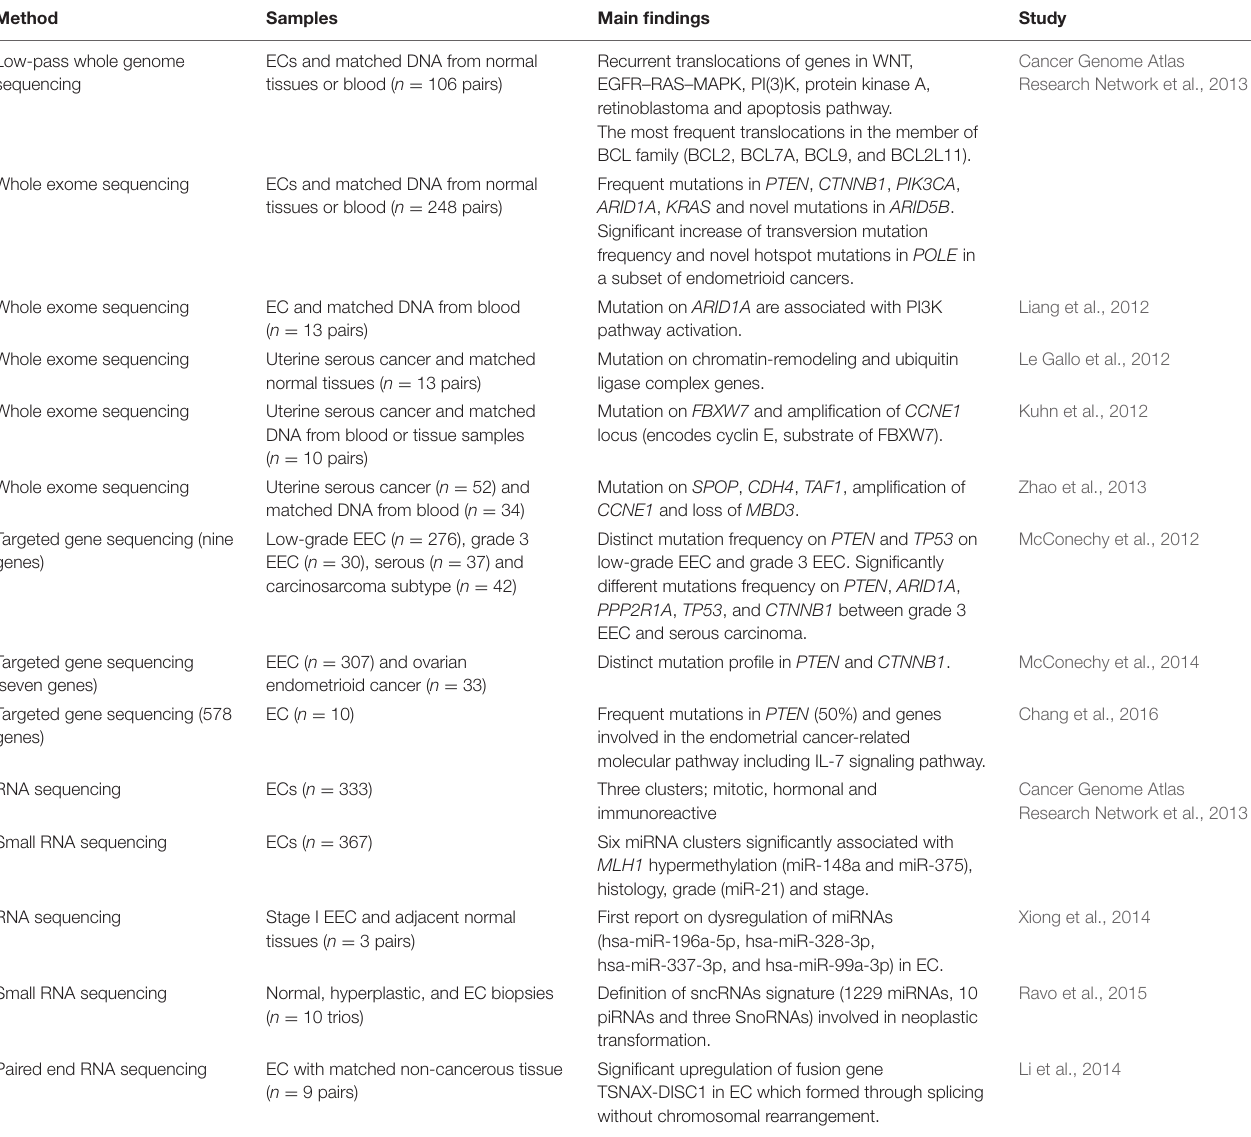
TABLE 1 | Main findings contributed by Next Generation Sequencing (NGS) in endometrial cancers